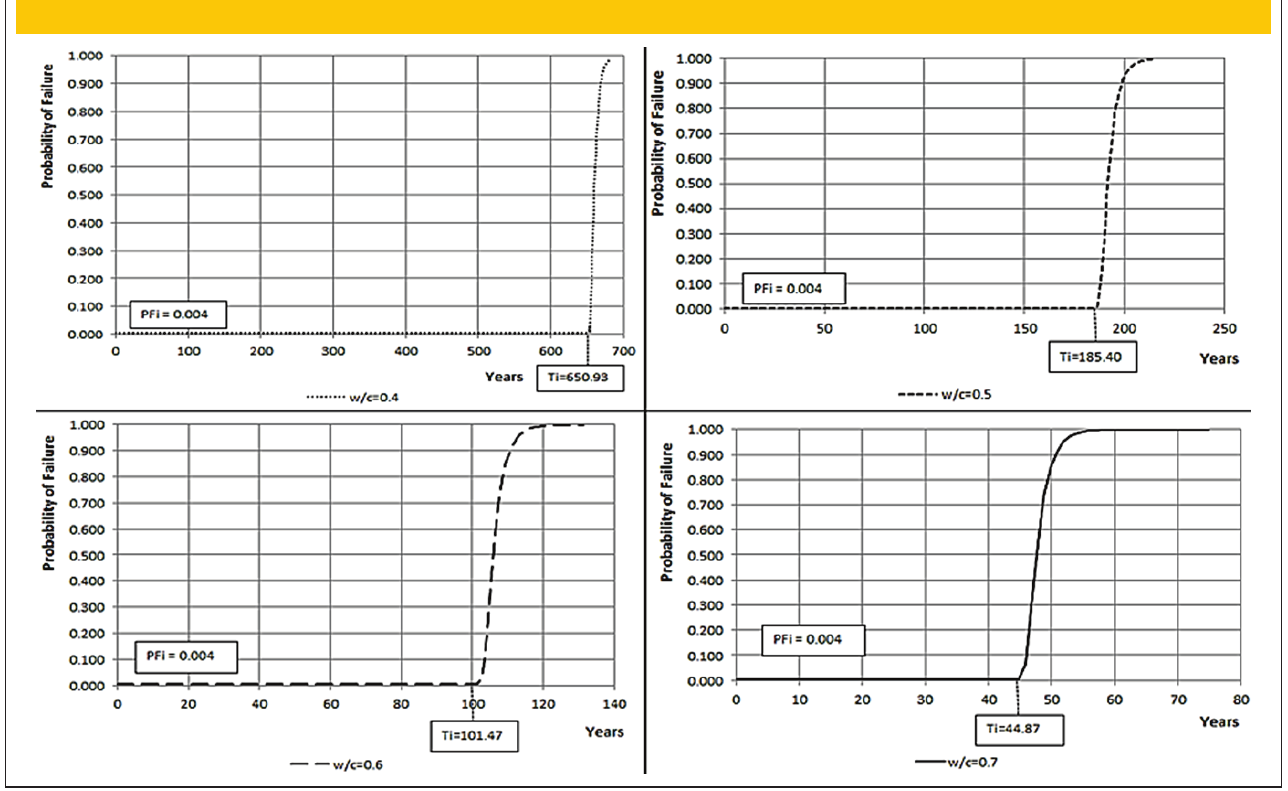
Figure 21 – Probability of failure along time for CA II and β x=0.628 double reinforcements'